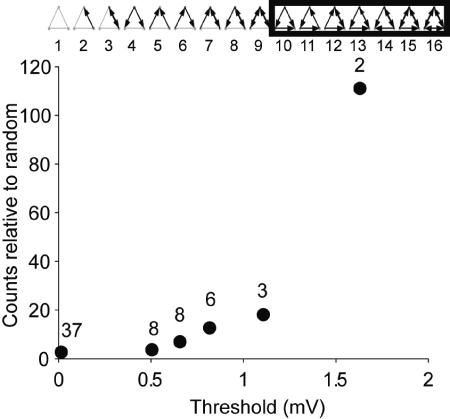
Stronger Connections Are More Clustered than Weaker OnesRelative overrepresentation of highly connected three-neuron motifs monotonically increases as the threshold is raised (counts differ from random p < 0.001 for all thresholds, Monte Carlo simulation). Significance of monotonicity is assessed by applying the Kolmogorov-Smirnov test (p <3.5 × 10−10 for all successive pairs). Numbers show the actual triplet counts. For the second to highest threshold, two instances of pattern 12 and one instance of pattern 16 survive. For the highest threshold, one instance each of pattern 12 and 15 survive (one of the connections in pattern 16 drops out and it becomes pattern 15).